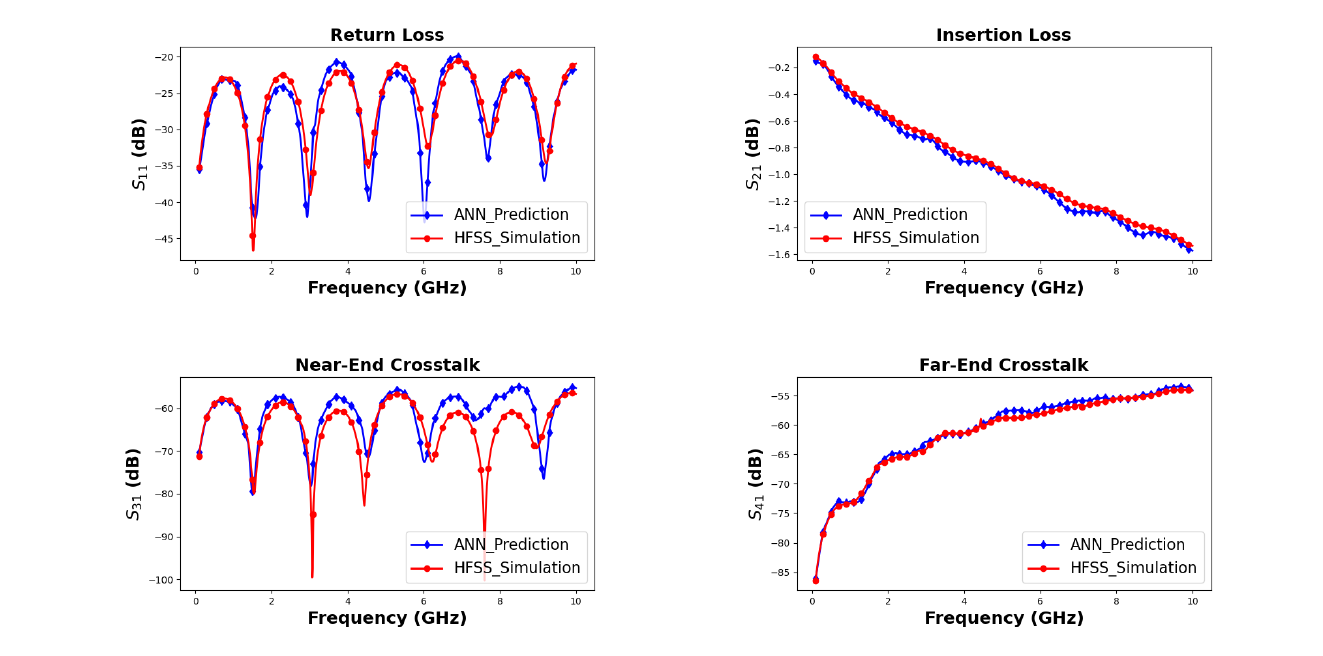
Figure 10. S-parameter prediction for the optimal structure W = 85 µ m, K D = 4.